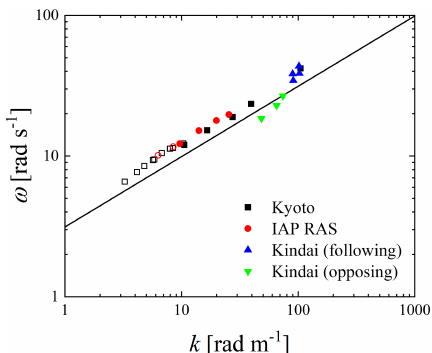
Figure 4. Dispersion relation between angular frequency ω and wavenumber k . Open symbols show the high-wind-speed cases. The curve shows the dispersion relation of the deepwater waves ( ω 2 = gk ).